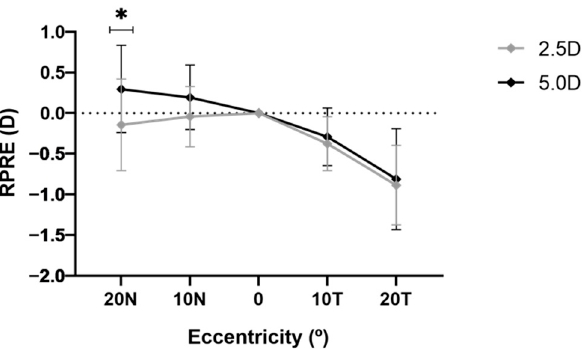
Figure 8. RPRE values for each eccentricity and accommodative demand. (* Statistically signifi-